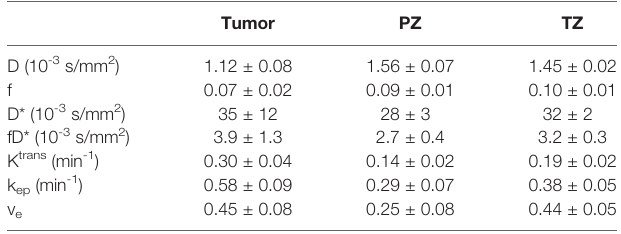
TABLE 3 | Pre-treatment values of the IVIM and DCE parameters.